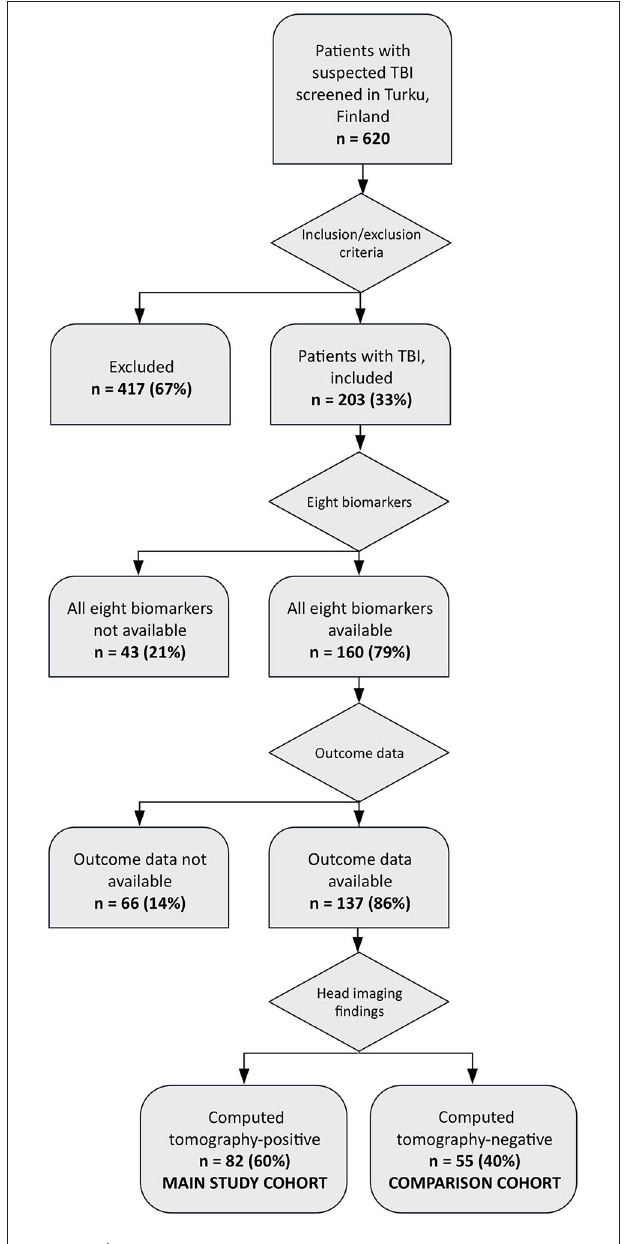
FIGURE 1 | Study recruitment flow